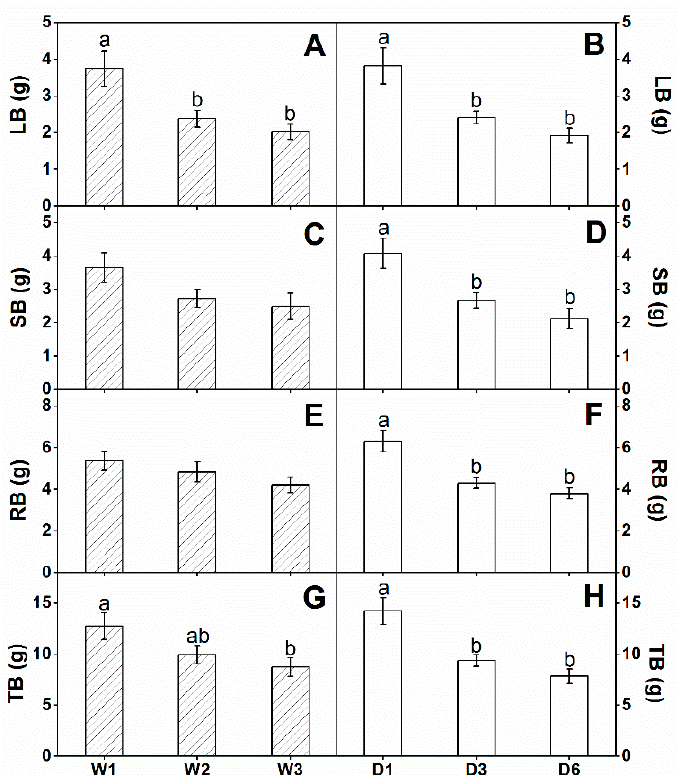
Figure 5. Comparisons of the biomass of R. pseudoacacia grown in different rainfall intensity and rainfall frequency treatments (mean ± SE, n = 6) at the end of the experiment. The LB ( A , B ), SB ( C , D ), RB ( E , F ), and TB ( G , H ). Bars ( A , C , E , G ) in the left graphs are the rainfall intensity treatments (W1, W2, and W3: 75%, 55%, and 35% of the field capacity, respectively). Bars ( B , D , F , H ) in the right graphs are the rainfall frequency treatments (D1, D3, and D6: every day, every 3 days, and every 6 days of watering, respectively). Different letters denote significant differences at p ≤ 0.05 by Tukey’s–HSD test.